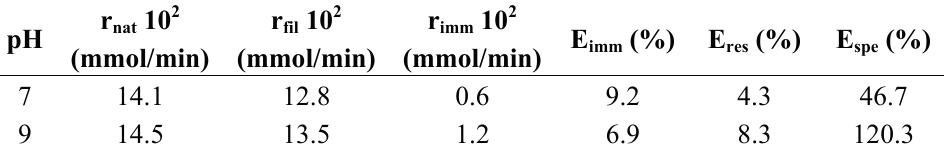
, residual activity, E , and specific imm res , determined from the corresponding values of spe , the activity of the filtrate in nat , and the activity of the immobilized enzyme, r , for the fil imm